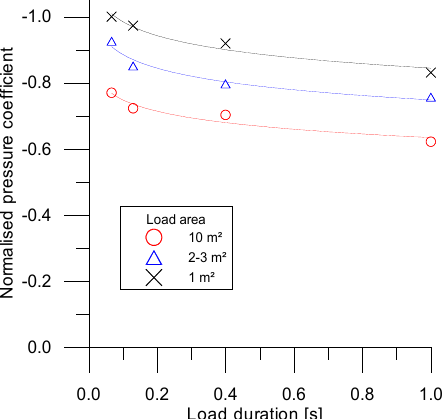
Figure 6. Example of normalised pressure coefficients as function of load duration and load area. The data shown is measured on the eastern facade of the Concert